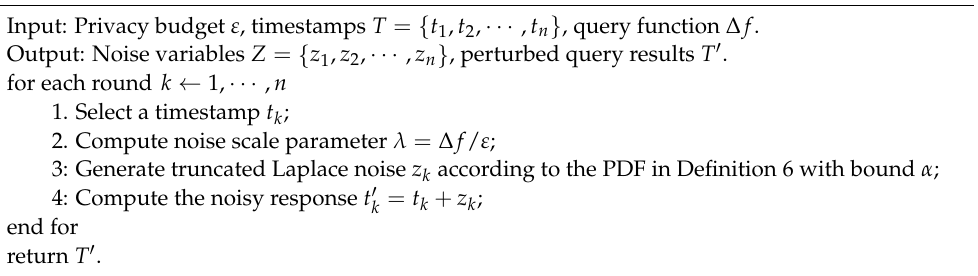
Algorithm 2: Truncated Laplace time perturbation